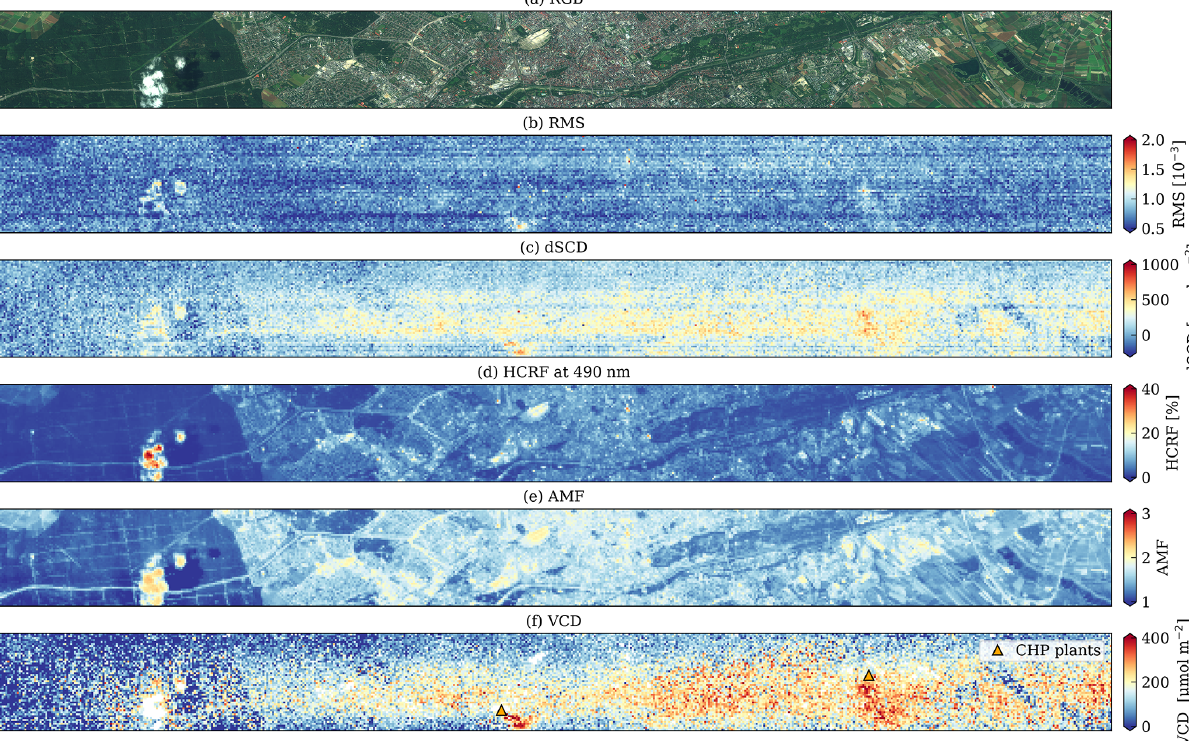
Figure 6. (a) True color image, (b) rms, (c) NO 2 differential slant column densities (dSCDs), (d) hemispheric–conical reflectance factors (HCRFs), (e) air mass factors (AMFs), and (f) NO 2 vertical column densities (VCDs) of the second APEX stripe (see Fig.